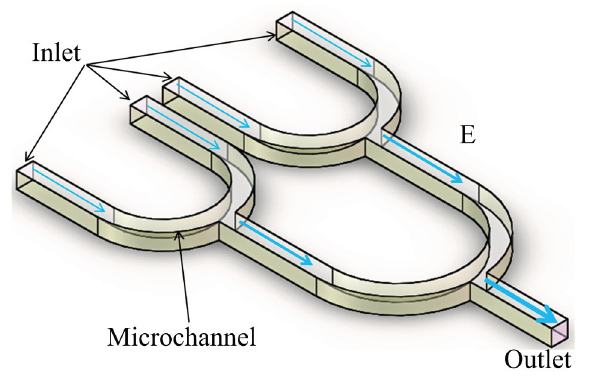
Figure 5. An insulating tree structure for electric field focusing